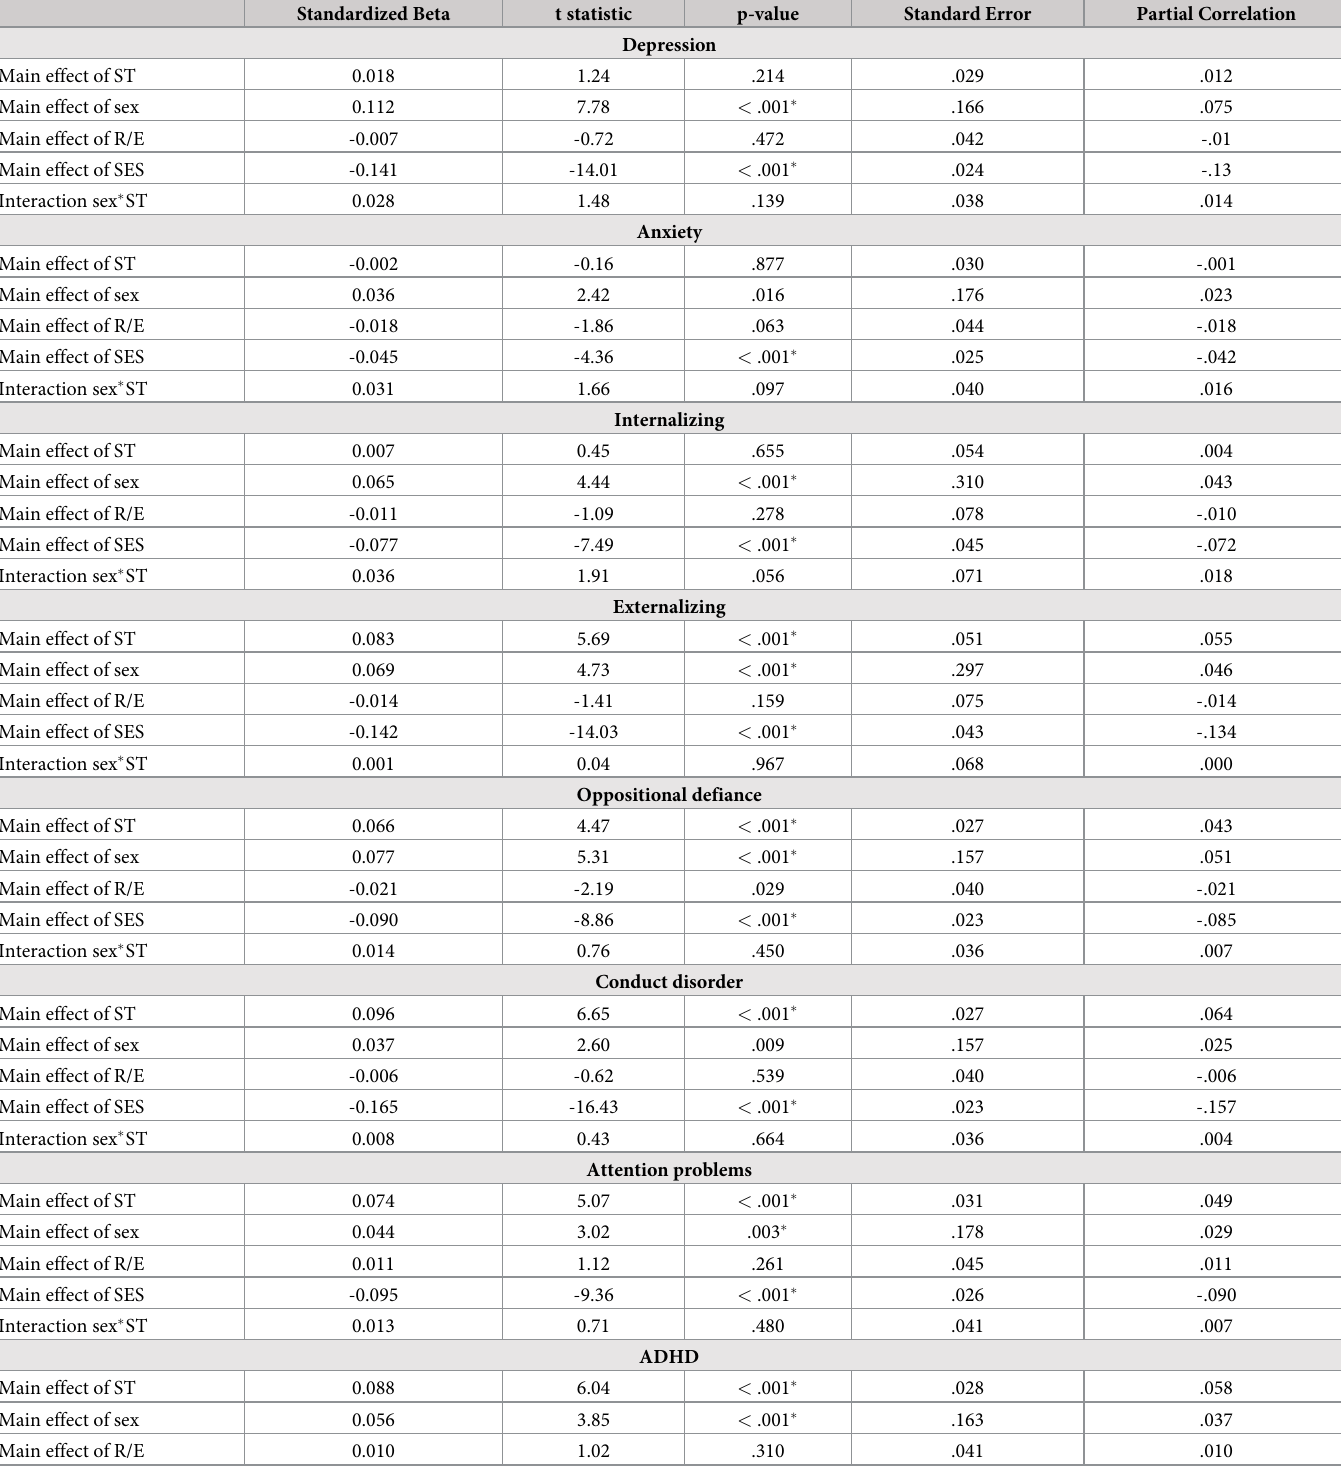
Table 2. Examination of main effects of weekday screen time and sex, as well as the interaction between them, on outcome variables, controlling for SES and race/